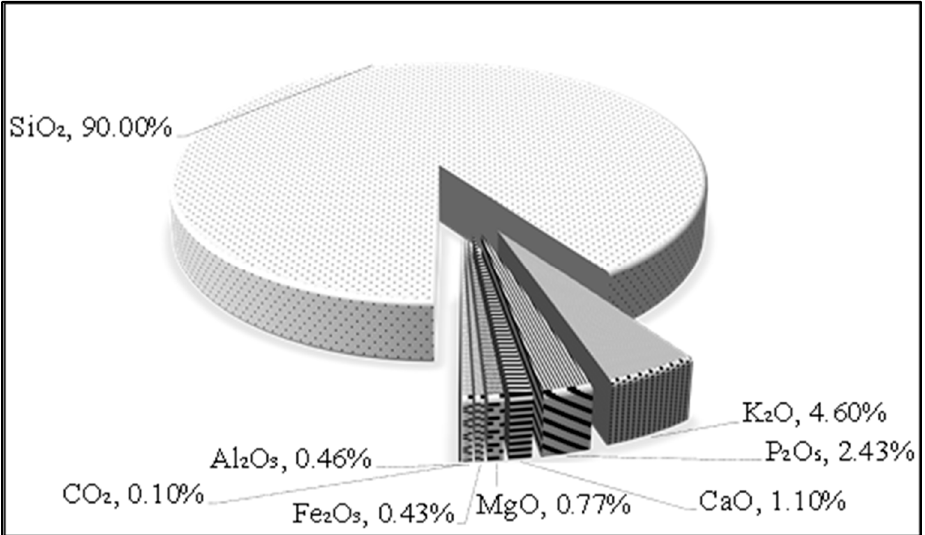
Figure 1. Chemical composition of RHA.